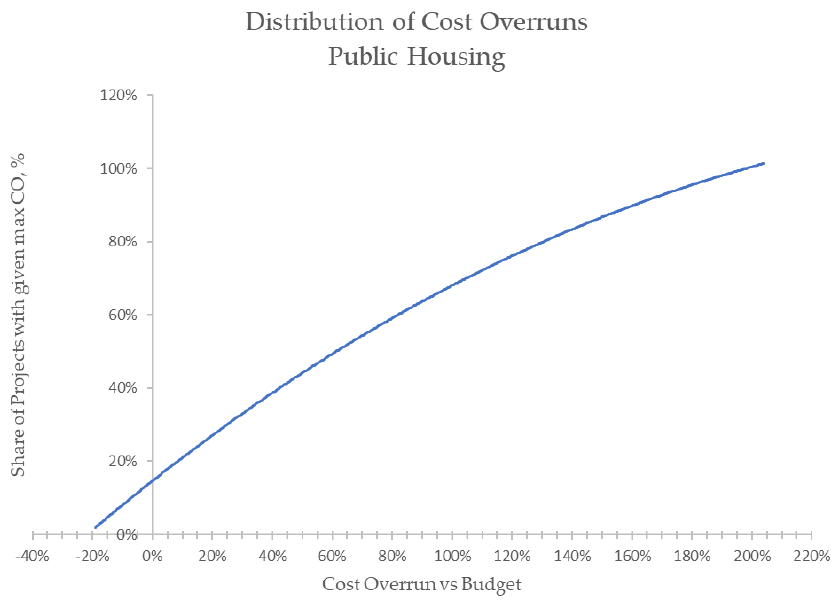
Figure 4. Illustration of cost overrun distribution in housing projects in Trinidad and Tobago.